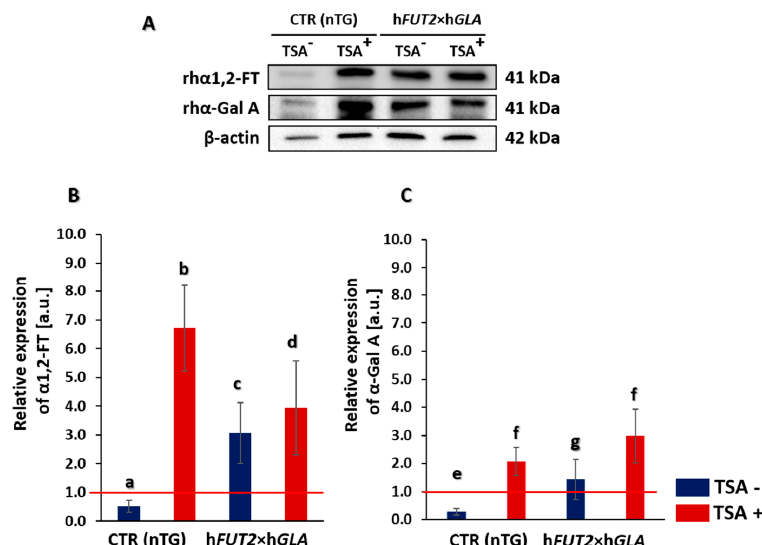
Figure 1. Western blot analysis of the relative expression of human α 1,2-fucosyltransferase ( α 1,2-FT) and α -galactosidase A ( α -Gal A) proteins in porcine bi-transgenic and non-transgenic adult cutaneous fibroblast cells (ACFCs) undergoing or not undergoing treatment with trichostatin A (TSA + and TSA − , respectively). Representative blots of the expression of α 1,2-FT and α -Gal A proteins in the ACFC samples derived from epigenetically modulated (TSA + ) and non-modulated (TSA − ) cells. The samples of non-transgenic animals served as a control group (CTR nTG—panel ( A )). β -Actin served as a loading control for all analyzed samples. The results of relative expression (in arbitrary units) of α 1,2-FT and α -Gal A are shown in panels ( B , C ), respectively. Relative optical density (ROD) from three separate analyses of at least three animals for each variant is expressed as mean. Bar graphs show mean ± standard error of the mean (SEM). The red line is taken as the cut-off value 1.0. Statistics: One-way ANOVA and Tukey’s honestly significant difference (HSD) post hoc test. The bars marked with different letters differ significantly; values denoted as a-b, a-d, b-c, b-d, e-f: p < 0.01; a-c, c-d, e-g, f-g: p <